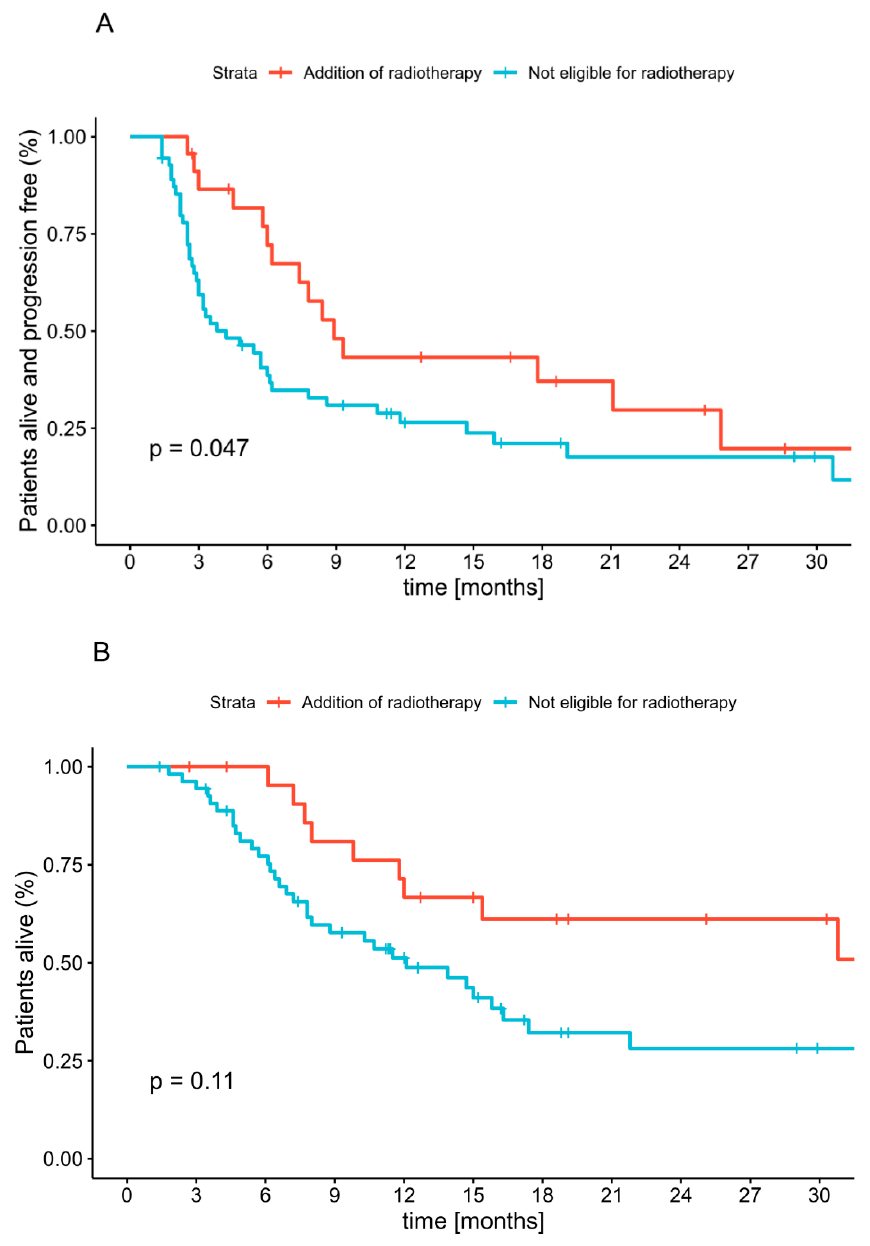
Figure 3. Progression-free survival ( A ) and overall survival ( B ) since the start of anti-PD1 therapy according to radiotherapy use.